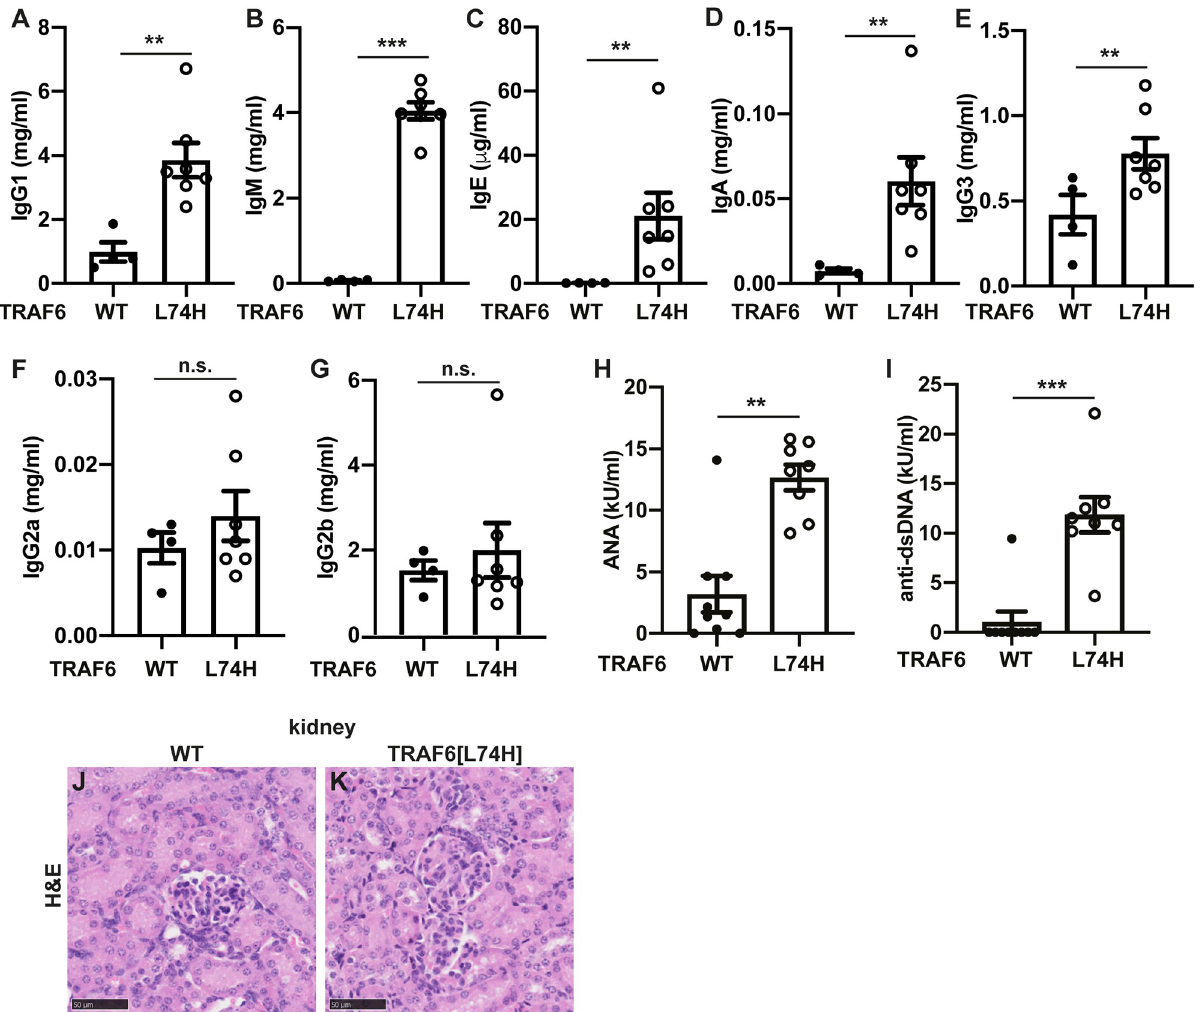
Fig 6. Increased immunoglobulin and autoantibody levels in TRAF6[L74H] mice. Concentrations of IgG1 (A), IgM (B), IgE (C), IgA (D), IgG3 (E), IgG2a (F) and IgG2b (G) in the serum of 16 days old WT (n = 7–9) and TRAF6[L74H] (n = 4–8) mice. (H-I) As in A-G, except that the plots show concentration of ANA (H) and anti-dsDNA (I) antibodies. The error bars show ± SEM. Symbols represent individual biological replicates. Statistical significance between the two genotypes was calculated using the unpaired t-test with Welch’s correction or the Mann-Whitney test. � denotes p < 0.05, �� denotes p < 0.01, ��� denotes p < 0.001 and n.s. denotes not significant difference. (J, K) Representative image showing haematoxylin and eosin (H&E)-stained liver sections from WT (J) and TRAF6[L74H] (K) mice. Individual values, descriptive statistics and results from the statistical analysis are provided in S6